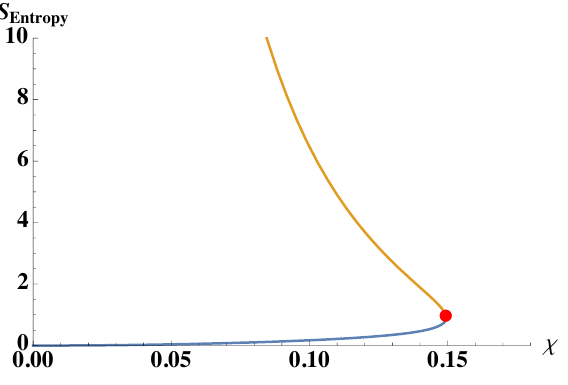
Figure 2 . Entropy vs. NUT charge χ for uncharged TB-AdS for κ = 1 and G = l = 1